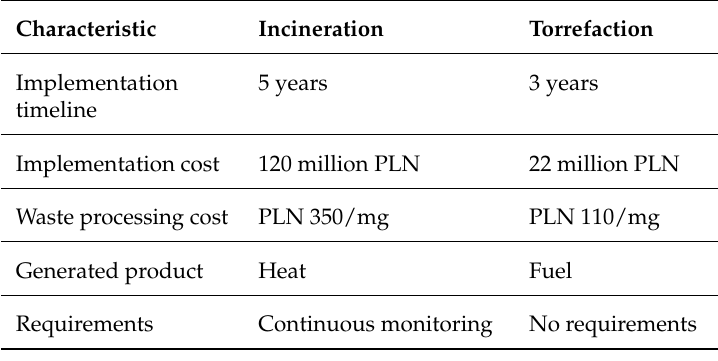
Table 7. Comparison of incineration vs. torrefaction